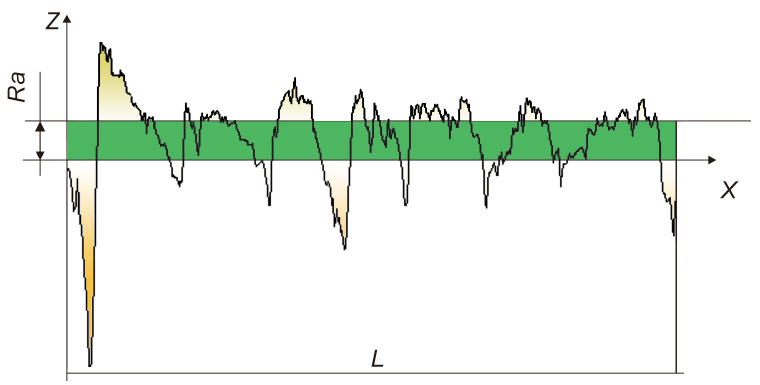
Figure 5. Surface roughness of the molding particle ( R a = 2.05 µ m).